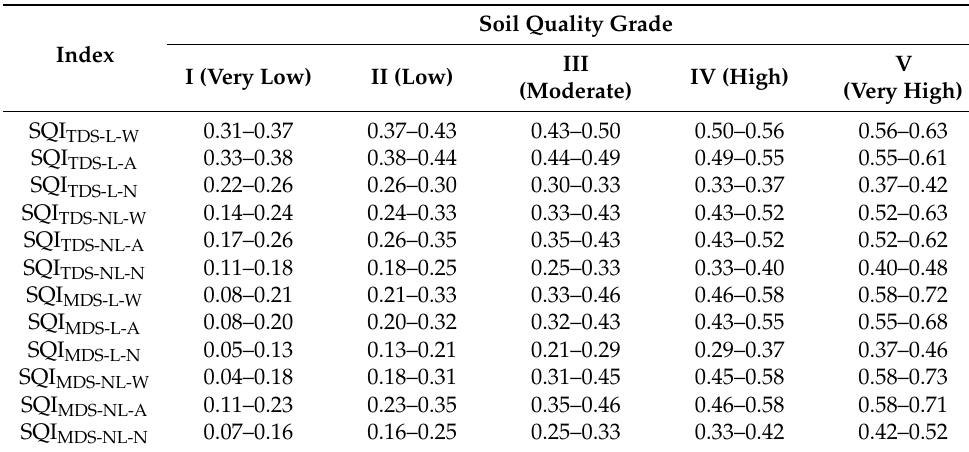
Table 5. Classification of grades of soil